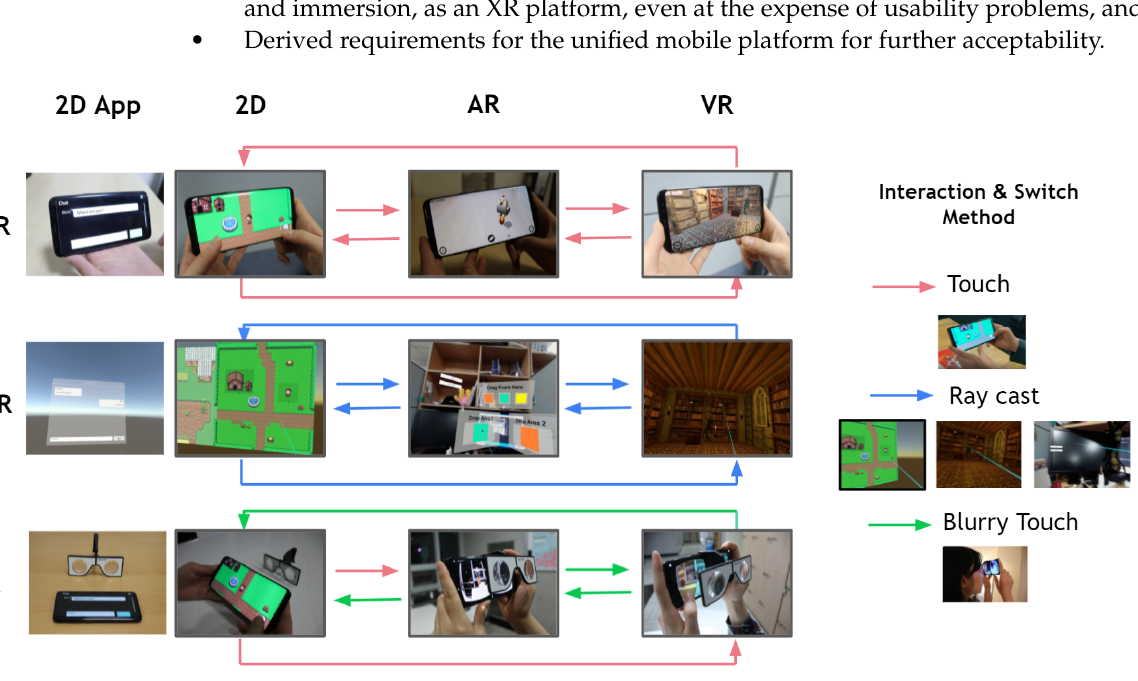
Figure 1. Three mobile Extended Reality (XR) platforms for multi-mode and multitasking among the regular app, 2D, AR and VR